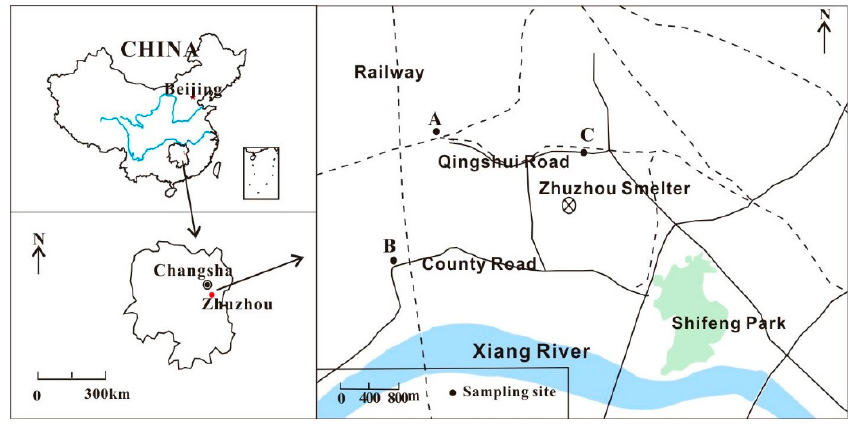
Figure 1. Locations of sampling sites in Zhuzhou City, Hunan .